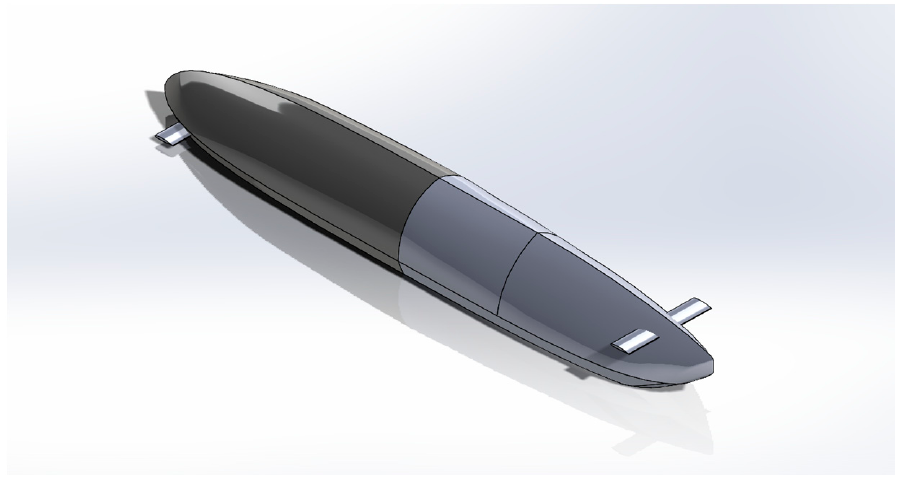
Figure 6. Isometric view of Phase-2 model.